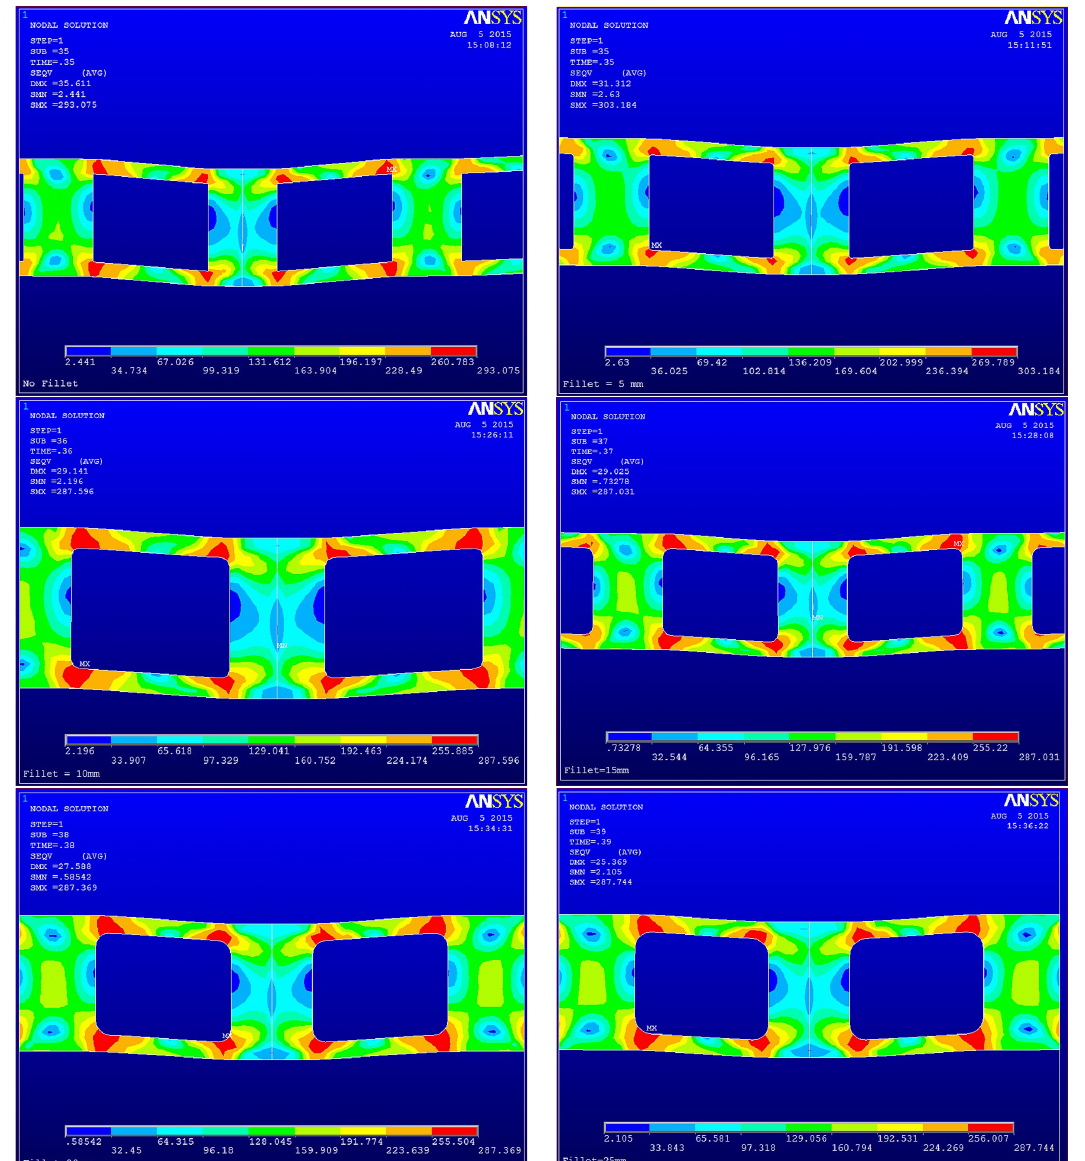
Fig. 13. Von-Mises stress distribution around the corners of opening for different fillet